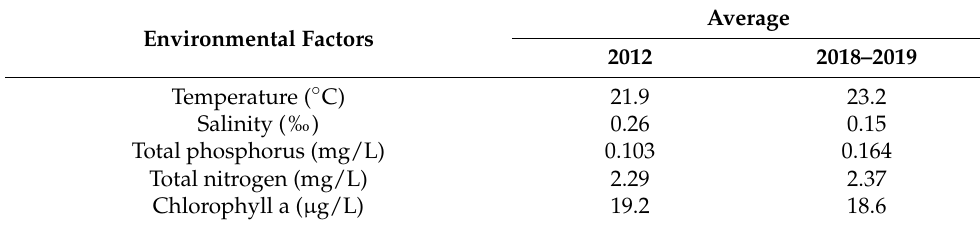
Table 2. Comparison of water environmental factors in 2012 and in 2018–2019.